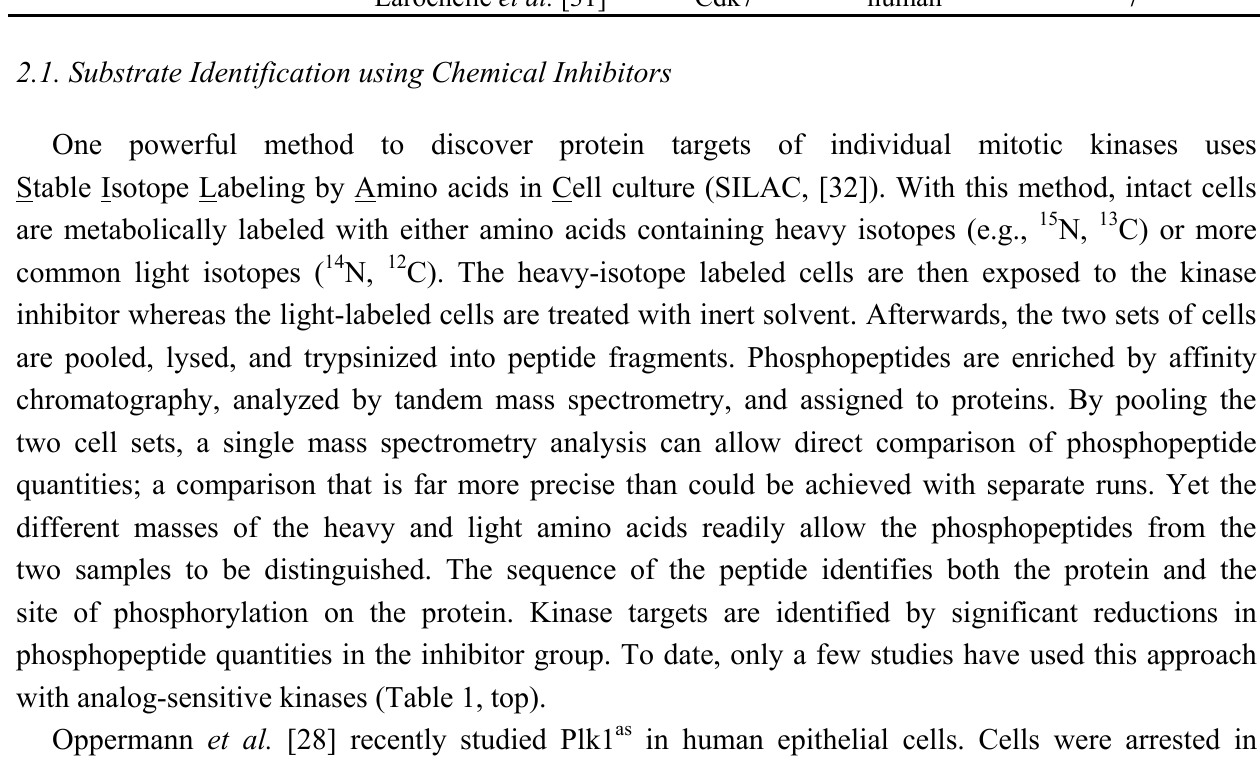
Table 1. Unbiased screens for protein targets of mitotic kinases using as-alleles. Strategy Authors as-kinase Organism Proteins Identified Oppermann et al. [28] Plk1 human Chemical inhibition in Koch et al. [21] intact cells